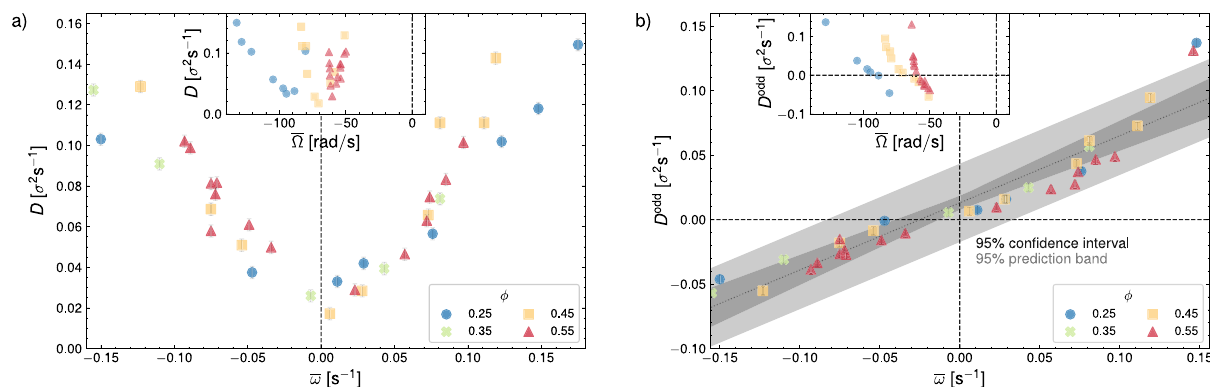
Fig. 3 Diffusion coef fi cients D , D odd vs. global mean vorticity ω . Results are represented for several experiments at different densities (each denoted with a different symbol and color, see fi gure legend). a Diffusion coef fi cient D (diagonal elements of diffusion tensor D , in eq. (1)). b Odd diffusion D odd coef fi cient (off-diagonal elements of D ). Con fi dence intervals of a linear regression from the experimental data for D odd appear shaded in gray. Insets display diffusion coef fi cients vs. particle activity (here, average particle spin Ω ). Notice that in the insets D odd changes sign at different points, contrary